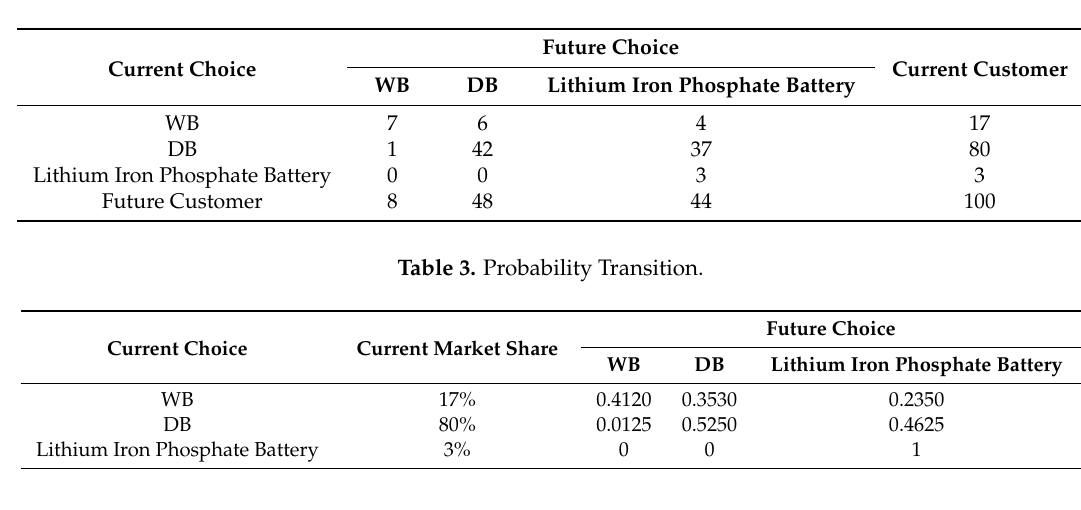
Table 2. Type Transition Pattern of Battery Consumer.